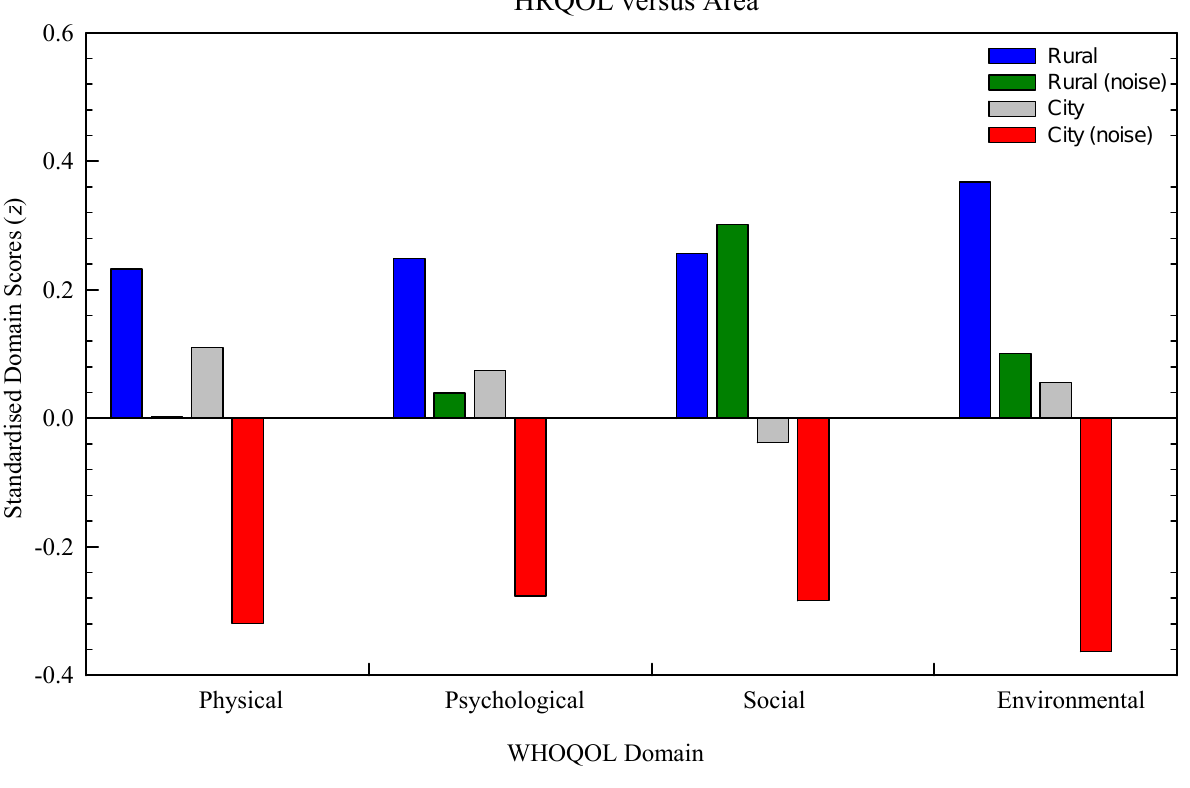
Figure 5. Mean standardised HRQOL scores plotted for the four WHOQOL-BREF domains and four areas differing in sound character.